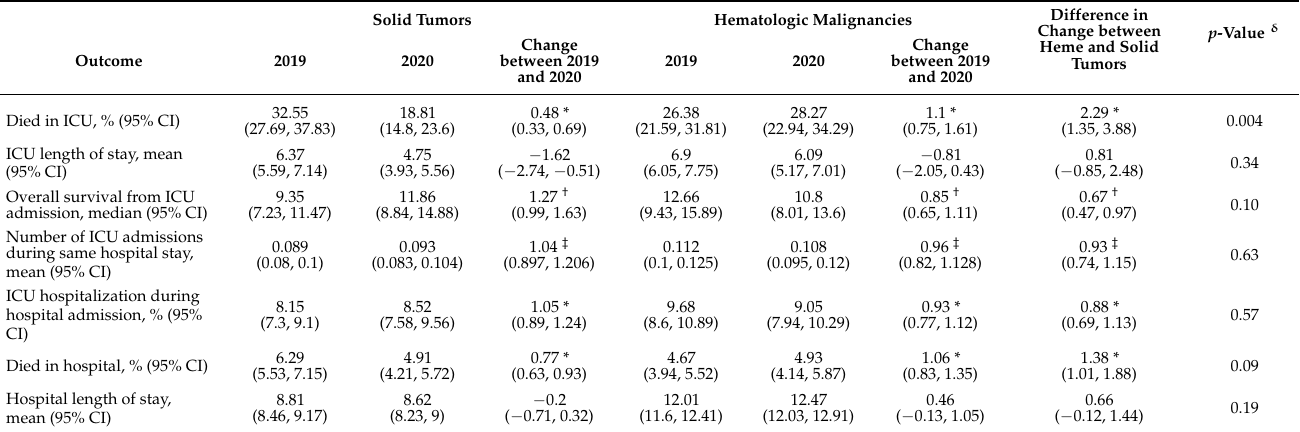
Table 2. Differences in hospitalization outcomes before and after myGOC implementation between patients with solid tumors and those with hematologic